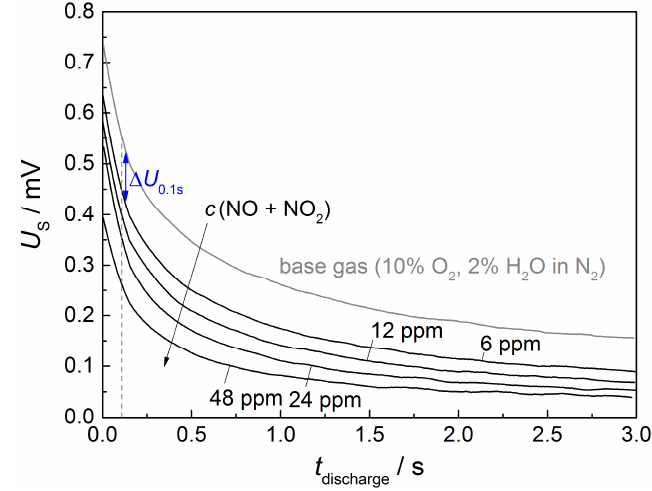
Figure 6. Example for a time-dependent sensor potential U S during self-discharge in base gas and under NO x concentrations between 6 and 48 ppm after alternating pulses. The sensor consists of an 8YSZ electrolyte produced by aerosol deposition and an overlying platinum electrode produced by screen-printing and sintering.